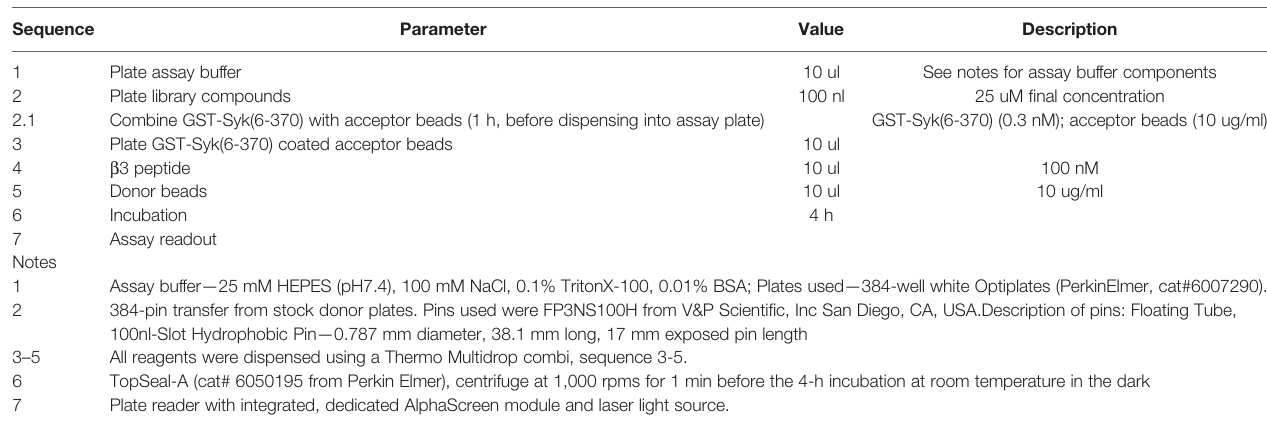
TABLE 1 | AlphaScreen Assay